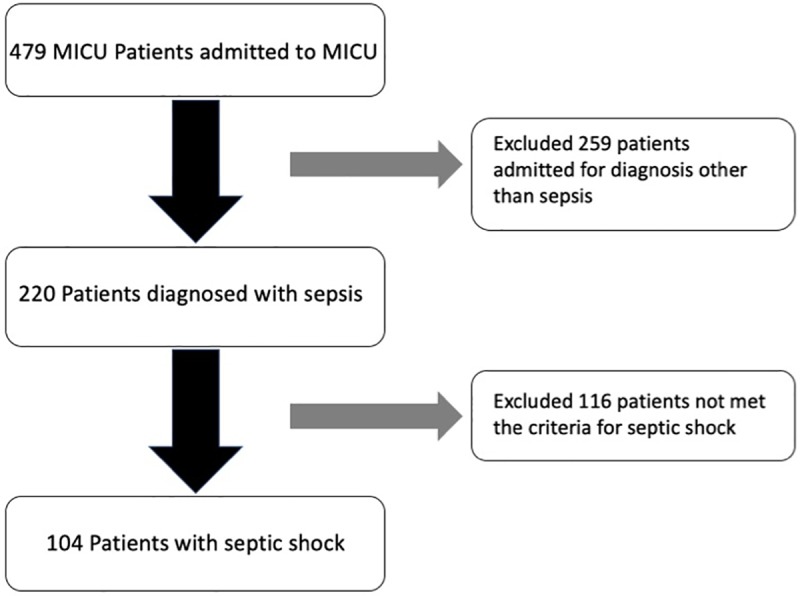
Patient flow chart.